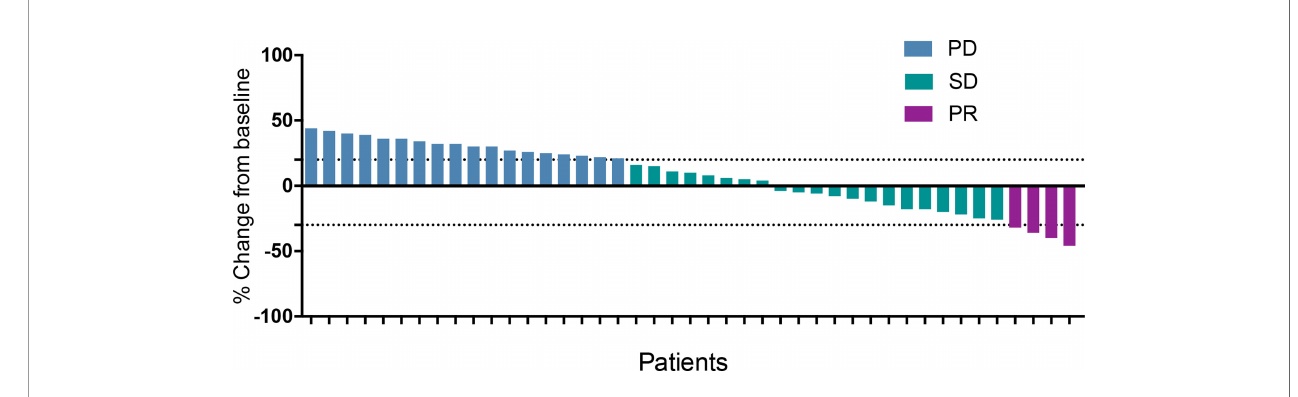
FIGURE 1 | Waterfall plot of the best response change.